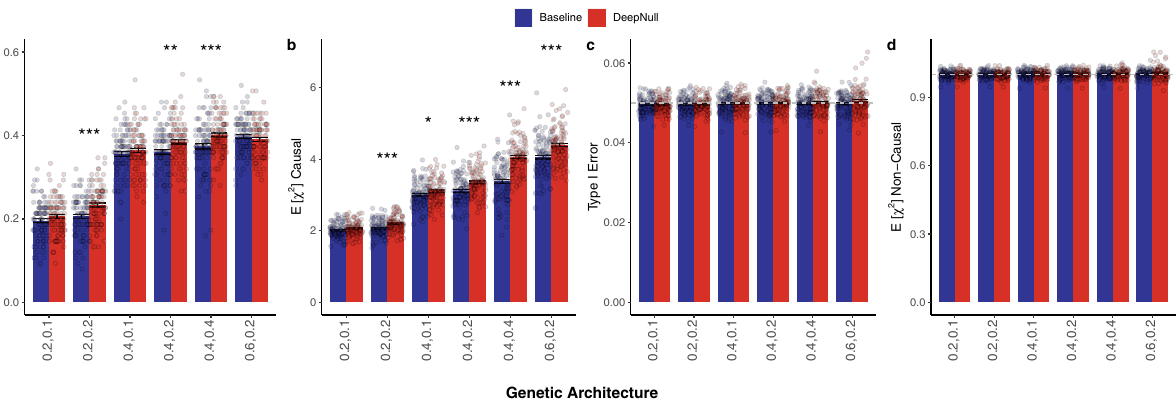
Fig. 2 DeepNull increases power in the presence of covariate interactions. a Statistical power, and ( b ) expected χ 2 statistics for variants in the causal chromosome ( chr22 ); ( c ) type I Error, and ( d ) expected χ 2 statistics for variants in the non-causal chromosomes ( chr1 and chr2 .). In the case of power and expected χ 2 statistics for the causal chromosome, higher is better. Methods should maintain a type I error of no more than 0.05, which is shown by the dashed gray horizontal line. For the non-causal chromosomes, the expected χ 2 statistics should be 1, which is also shown in dashed gray horizontal line. X-axis values indicate the proportion of phenotypic variance explained by genotypes and covariates, respectively. Error bars are the standard error of the mean for each estimate and each bar plot summarizes results from n = 100 independent simulation replicates. The numerical results are shown in Supplementary Table 5. Indicators for P value (Wilcoxon signed-rank one-sided test) ranges: * P ≤ 0.05, ** P ≤ 0.01, *** P ≤ 0.001. Source data are provided as a Source Data fi le. Table 1 DeepNull improves association results relative to the Baseline model on ten phenotypes from the UK Biobank. Pheno